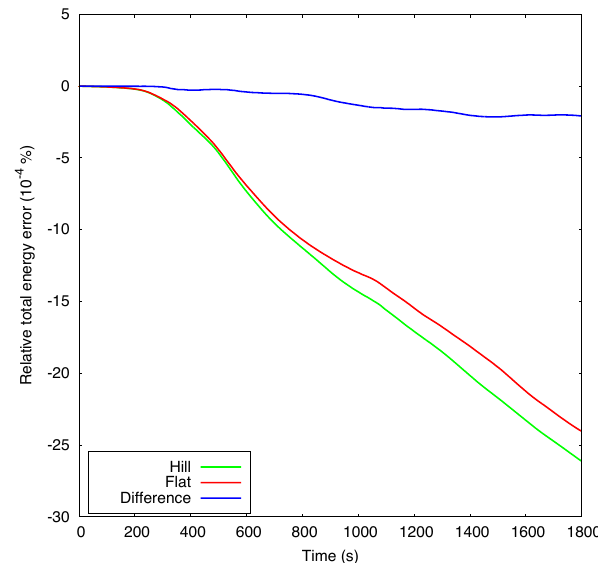
Figure 9. Time series of total energy error for the density current test case with and without the hill. The error is expressed as 10 − 4 % of the total energy at the beginning of the simulation.